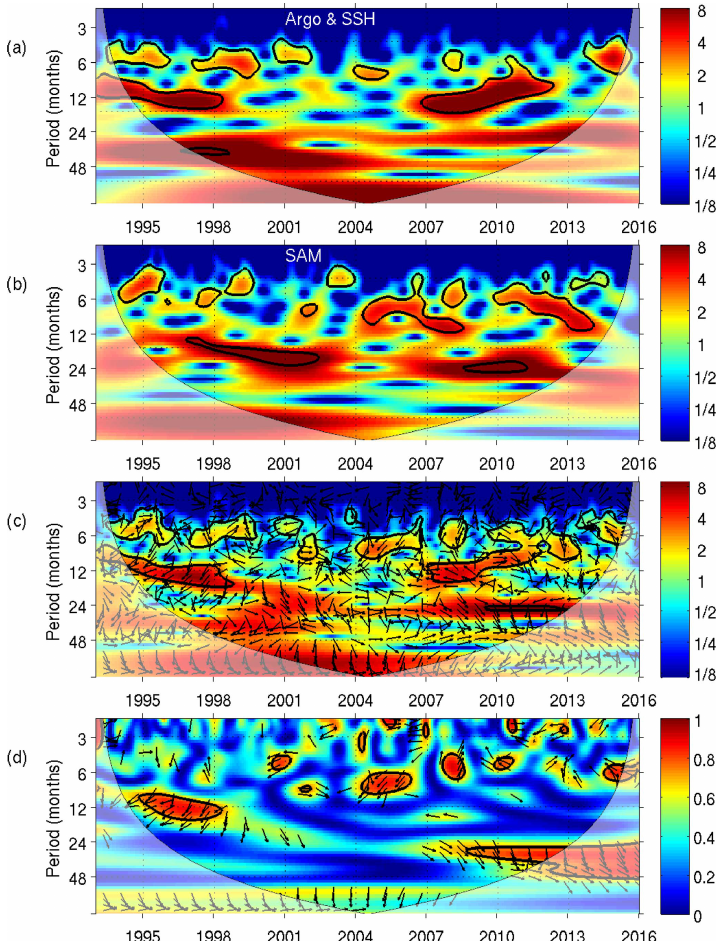
Figure 7. Wavelet power spectrum at 24 ◦ S for the Brazil Current transport from Argo&SSH (a) and SAM (b) . Panel (c) shows the cross wavelet power spectrum between the Brazil Current transport from Argo&SSH and SAM while (d) shows the coherence. The vectors in the lower panel indicate the phase difference between them. The thick black line is the 5% significance level using the red noise model, and the thin black line indicates the cone of influence. The time series were smoothed in the same way as the time series of the Brazil Current transport in Fig.